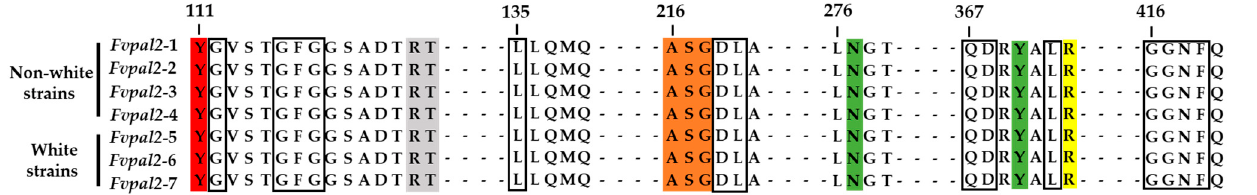
(non ‐ white), F. velutipes ASI4057 (non ‐ white), F. velutipes ASI4166 (white), F. velutipes ASI4167 (white), F. velutipes ASI4169 (white). Figure S2: Amplification refractory mutation system (ARMS) PCR of Fvpal1 in monospores from Flammulina velutipes ASI4175 (heterozygote, non ‐ white) (a) and w1 ‐ 8 (homozygote, white) (b) strains. Asterisks indicate F. velutipes monospores without mutation in the Fvpal1 gene. Figure S3: Alignments of phenylalanine ammonia ‐ lyase 2 ( Fvpal2 ) genes of Flam ‐ mulina velutipes strains. (a) cDNA sequence and (b) amino acid sequence. F. velutipes KACC42870 (non ‐ white), F. velutipes ASI4208 (non ‐ white), F. velutipes ASI4049 (non ‐ white), F. velutipes ASI4057 (non ‐ white), F. velutipes ASI4166 (white), F. velutipes ASI4167 (white), and F. velutipes ASI4169 (white). Table S1: White ‐ color ‐ specific variations identified in Flammulina velutipes strains. Table S2: Predicted gene models of Flammulina velutipes KACC42780.